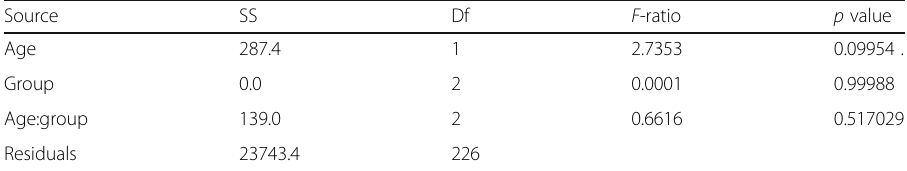
Table 2 Analysis of covariance (ANCOVA) of pre-test scores Source SS Df F -ratio p value Age 287.4 1 2.7353 0.09954 . Group 0.0 2 0.0001 0.99988 Age:group 139.0 2 0.6616 0.517029 Residuals 23743.4 226 Significant code: “ *** ” .001, “ ** ” .01, “ * ” .05, “ . ” .1, “ ”